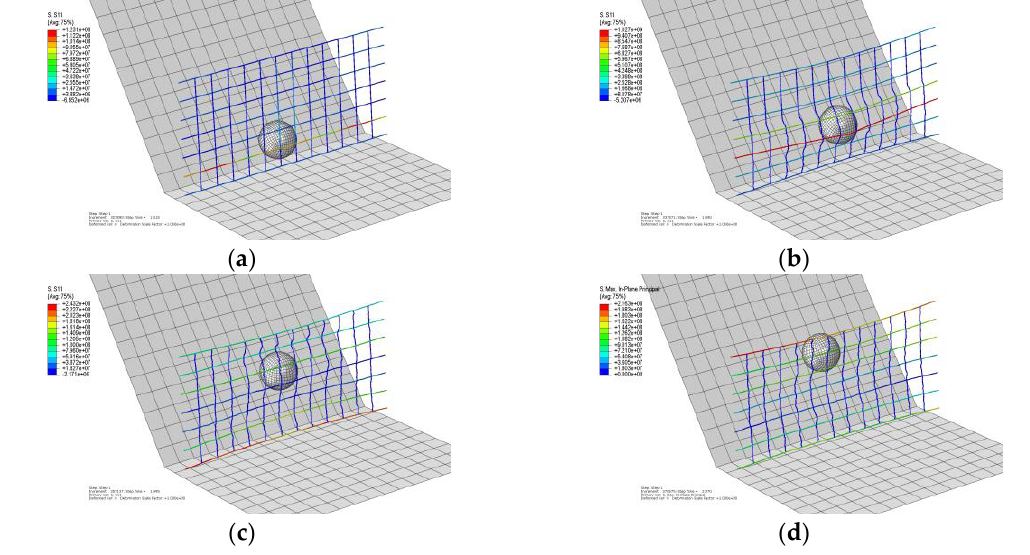
Figure 13. Stress distribution in the net protection system after impact, without using brake frame, ( a ) 0.015 s after impact; ( b ) 0.09 s after impact; ( c ) 0.195 s after impact; and ( d ) 0.27 s after impact.